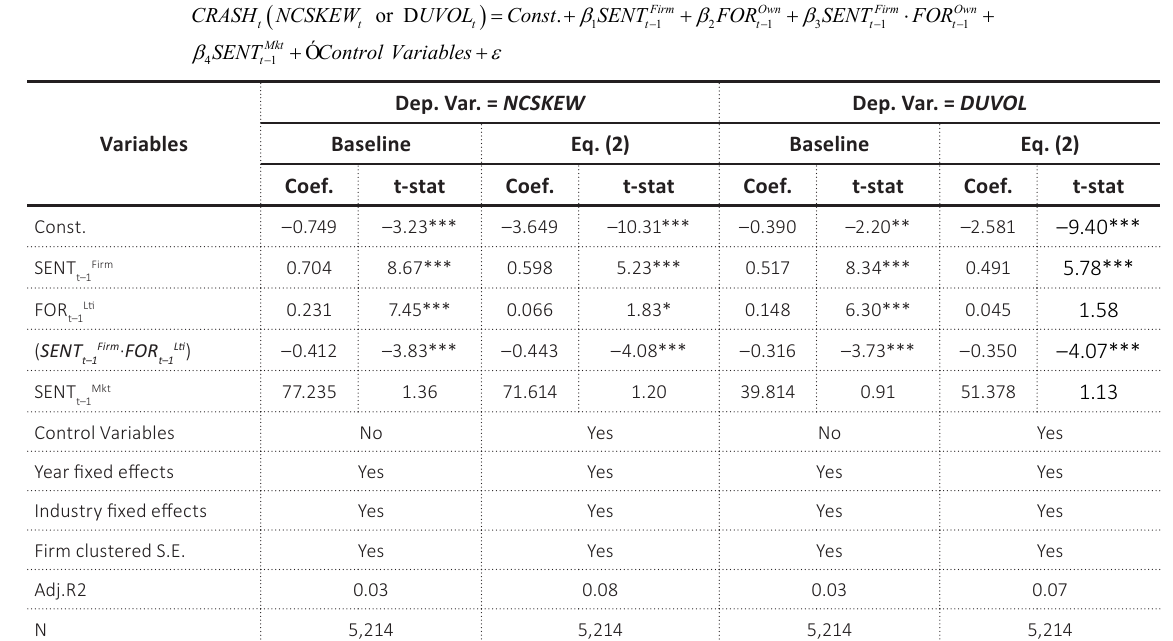
Table B4. Additional test: The role of foreign investors (foreign investment